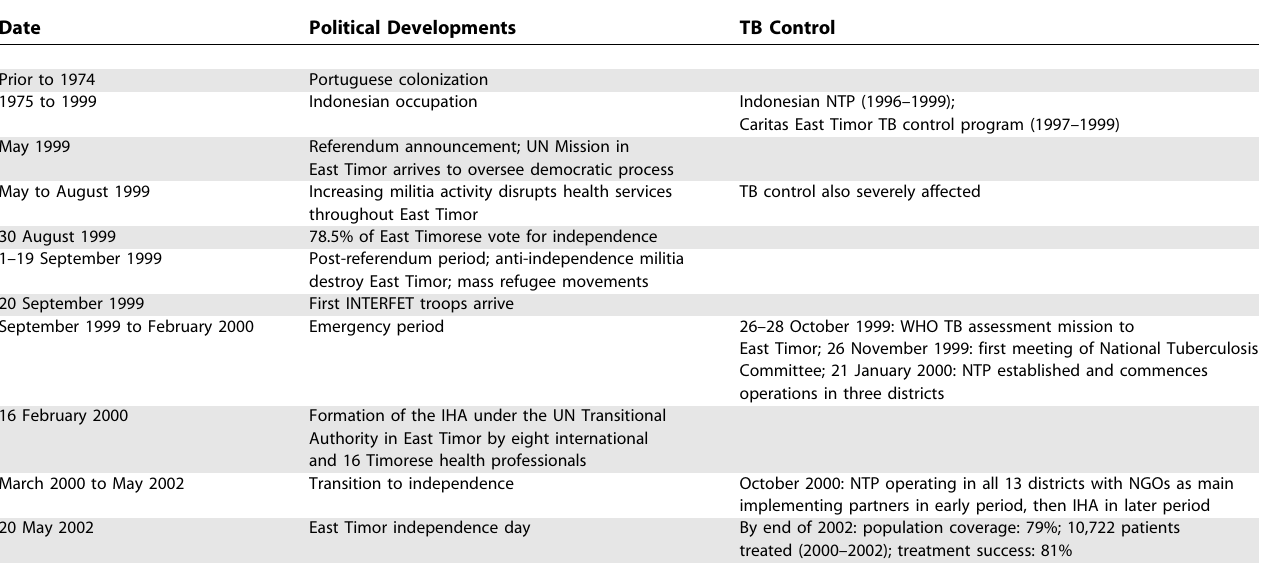
Table 1. Timeline of Key Political and TB Control Developments in East